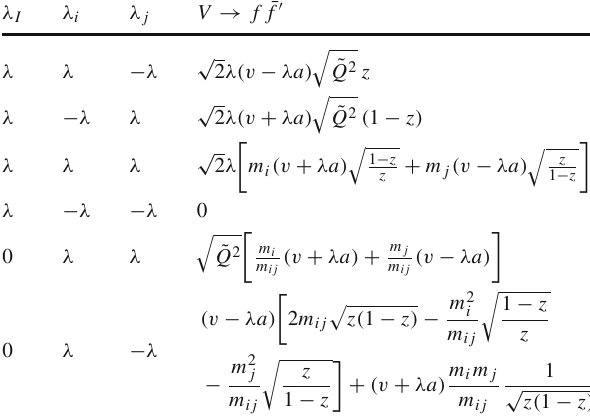
Table1 Branchingamplitudesforvectorbosonemissionoffafermion. Table 2 Branching amplitudes for vector boson splitting to fermions